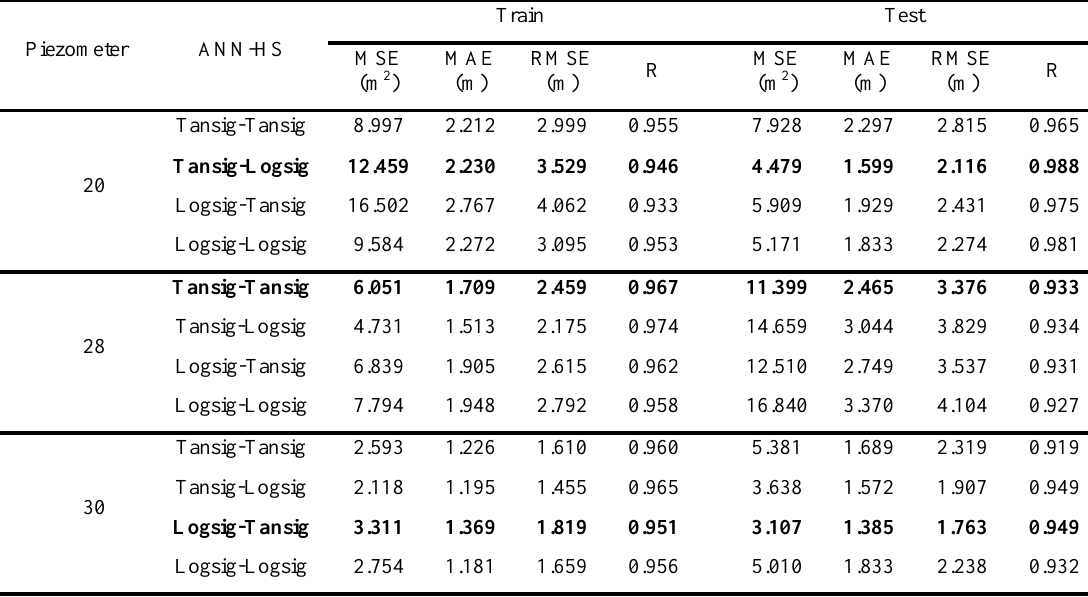
Table 5- Results of combining ANN-HS in order to simulate water level variations of piezometers